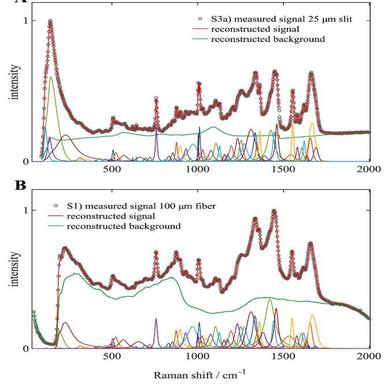
Regularized pure component model transfer of lysozyme model derived from S3a) to S1; A) reference lysozyme spectrum acquired with a slit width of 25 μm and pure component model; B) model transfer to S1) for a slit and fiber width of 100 μm; in dark green the reconstructed background consisting of BGPD (lens, microscopy slide) and BGBB is plotted; in subsets (A–B) the instrumentally broadened Raman peaks (multicolored) are plotted additionally to the reconstructed signal (red). (For interpretation of the re